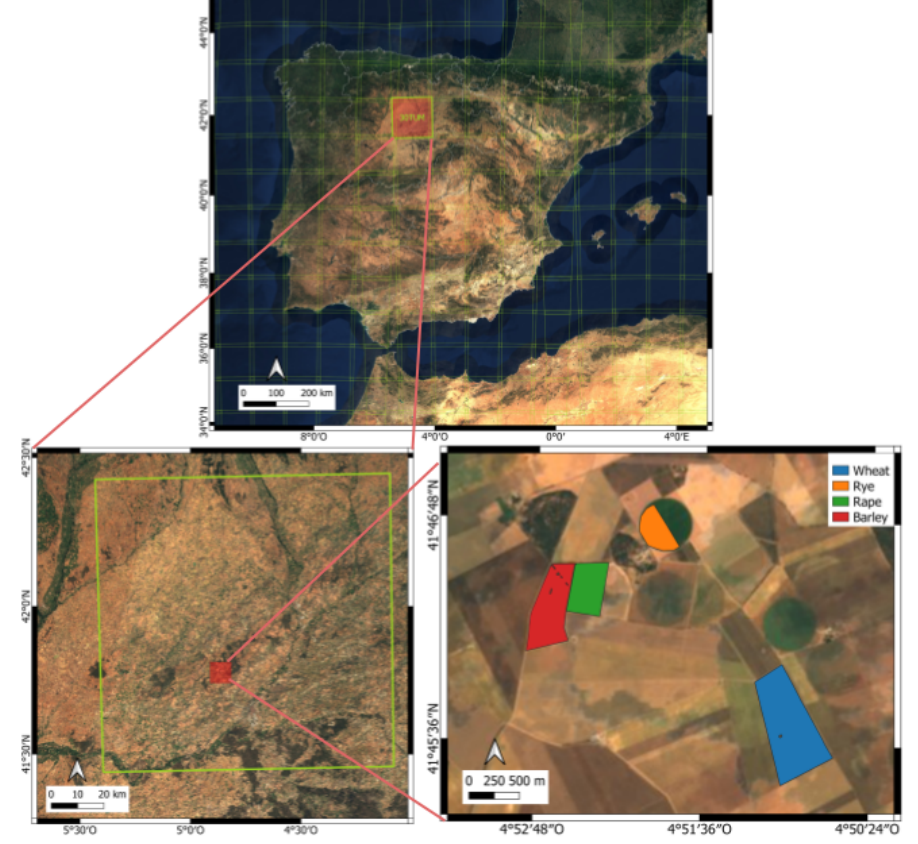
Figure 2. RGB map of the Iberian peninsula (top), the S2 tile 30TUM (Military Grid Reference System) ( left ), and a zoom-in of the crops in the Region Of Interest (ROI) ( right ). Pixels inside the colored region were used for the per-parcel LSP